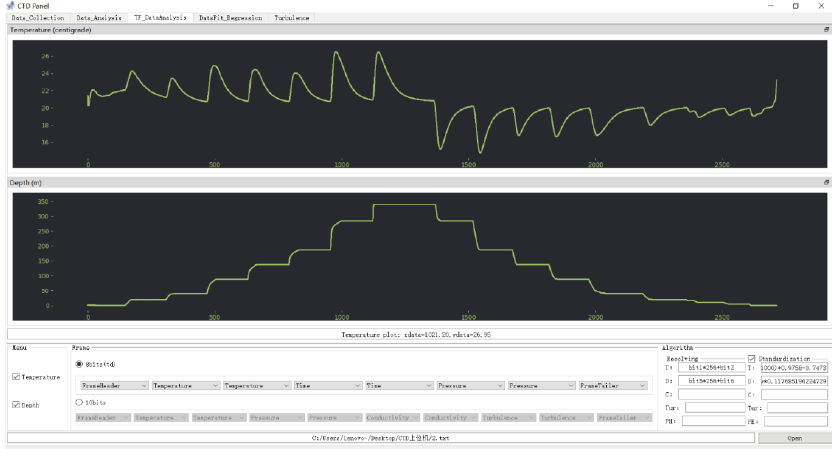
Figure 19. Interface diagram of the host computer.